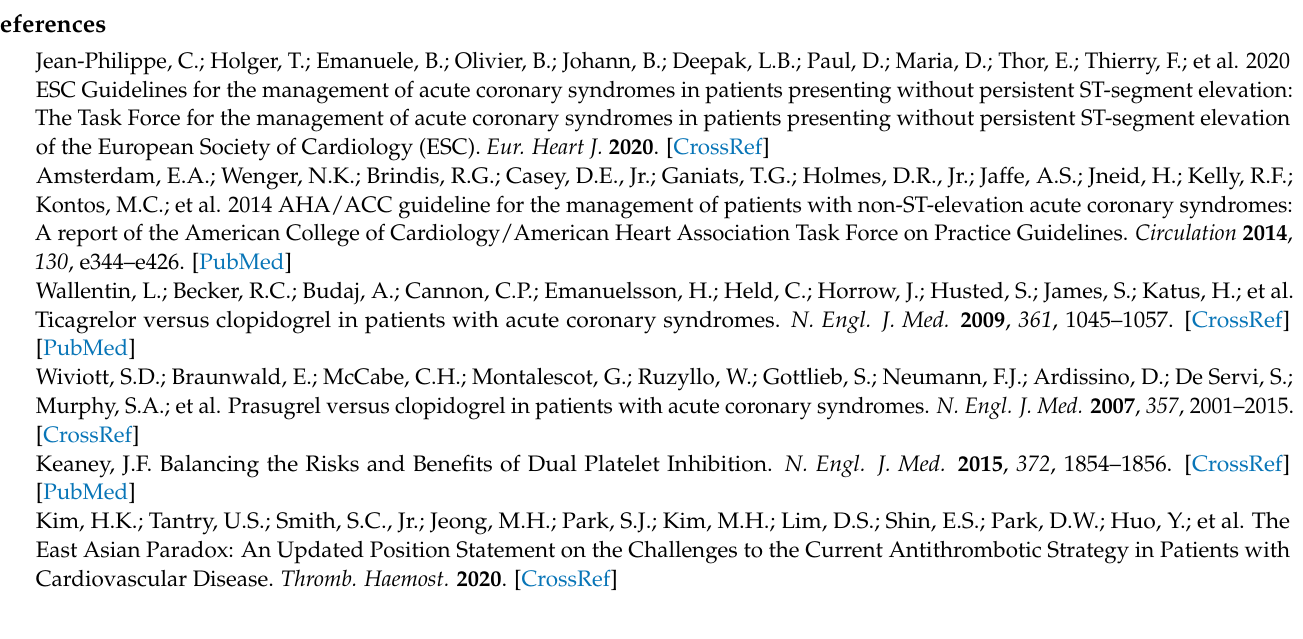
Table S2. Comparison of ischemic endpoints between groups by Cox proportional regression analysis, Table S3. Relationship between bleeding events and